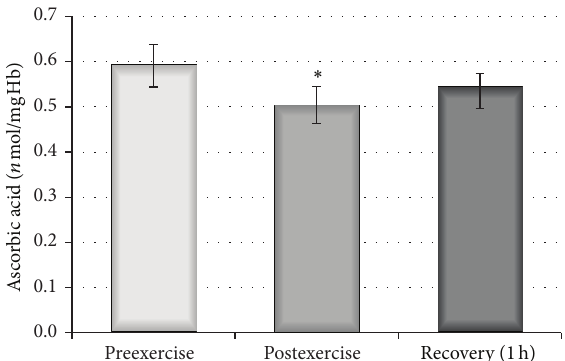
Figure 3: Changes in ascorbic acid concentration inside the ery- throcytes before, after, and 1 hour after exercise. ∗ indicates signifi- cant difference between preexercise and postexercise ( 𝑃 < 0.005